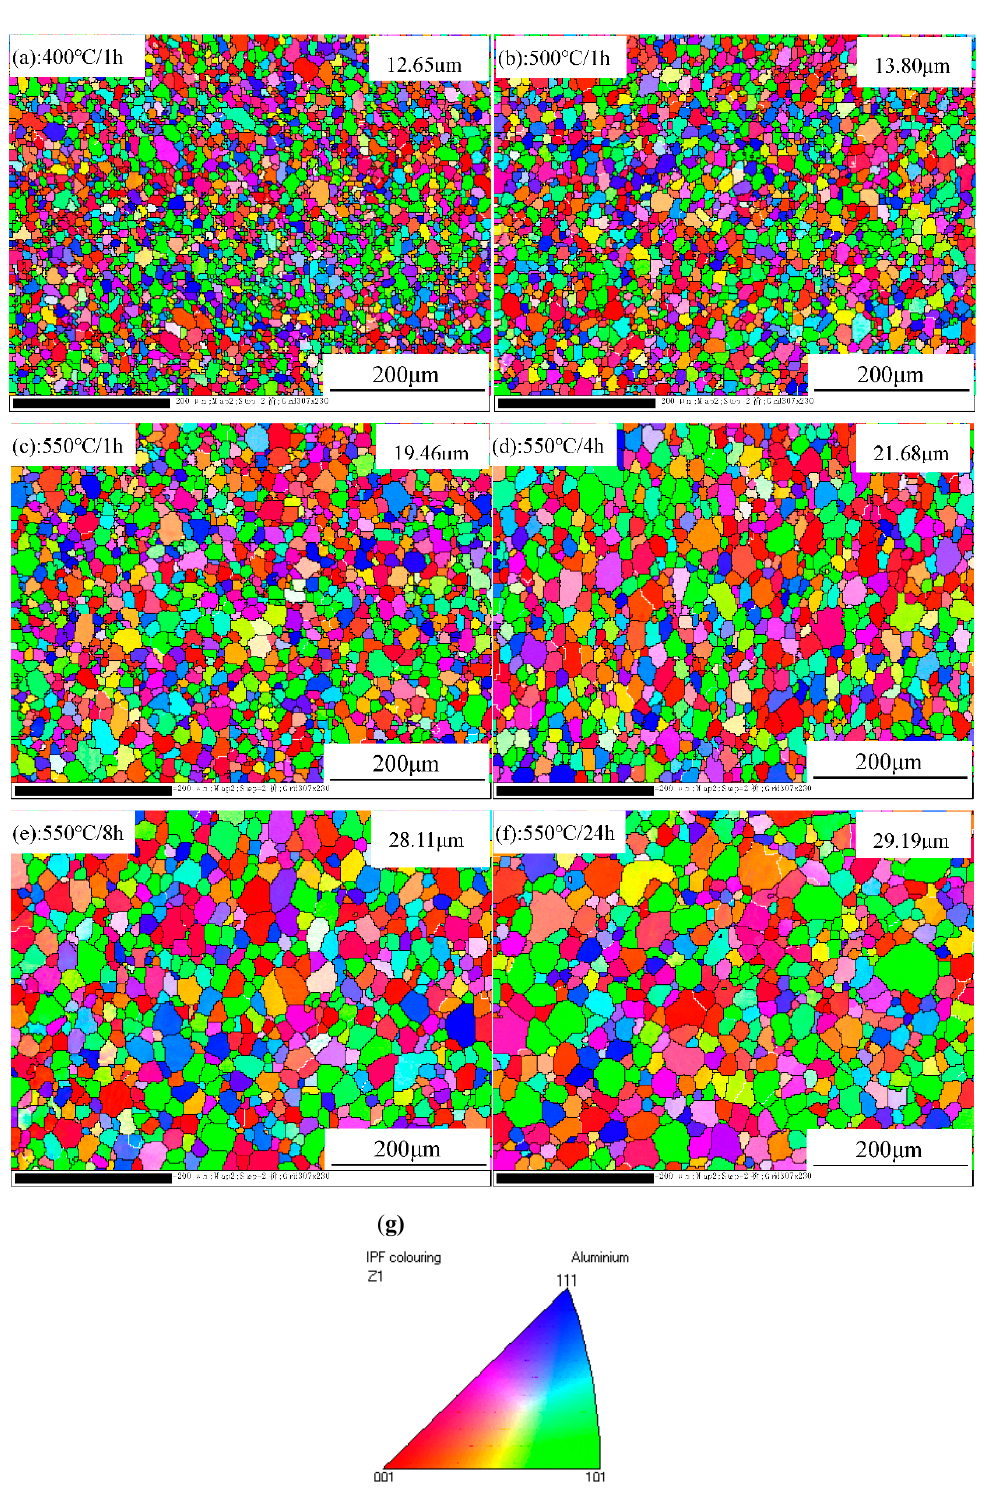
Figure 4. EBSD mapping of 3104 sheets after various annealing treatments: ( a ) 400 ◦ C / 1 h; ( b ) 500 ◦ C / 1 h; ( c ) 550 ◦ C / 1 h; ( d ) 550 ◦ C / 4 h; ( e ) 550 ◦ C / 8 h; ( f ) 550 ◦ C / 24 h; ( g ) orientation triangle for EBSD